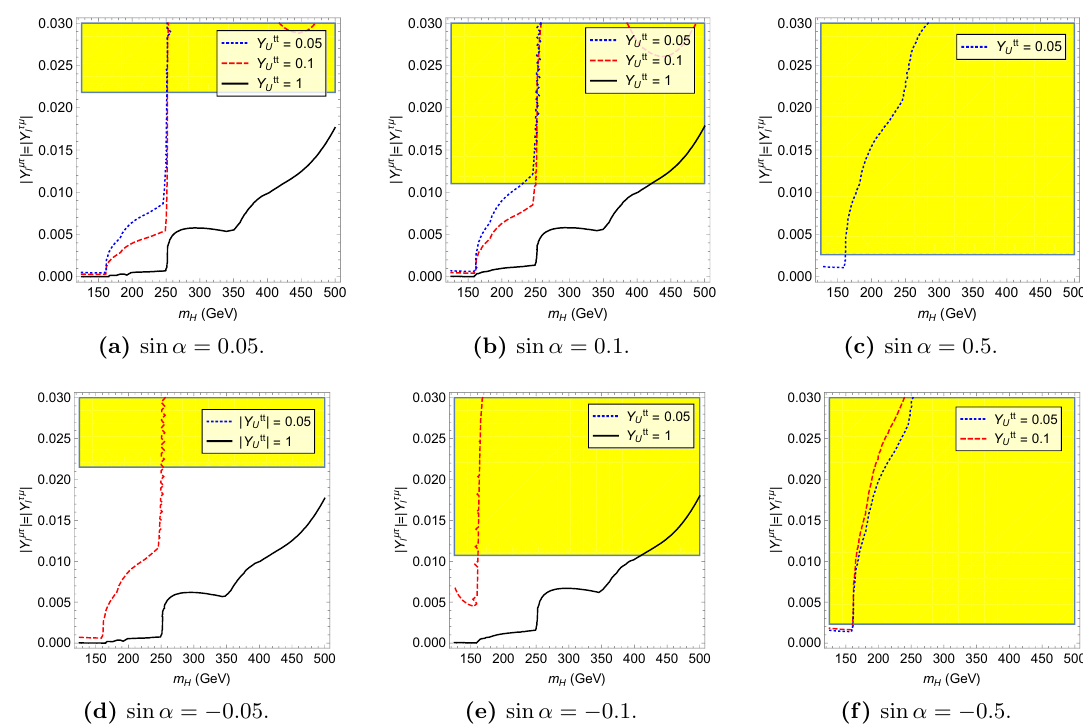
Figure 16. The estimated bounds for the heavy scalar LFV searches and their comparisons with the h LFV searches. The yellow region is excluded by the h LFV search. The region above the red, blue and black lines are excluded by the heavy scalar LFV search. Here we assume (cid:21) hhH = 1, m H < 2 m A and m H < 2 m H +